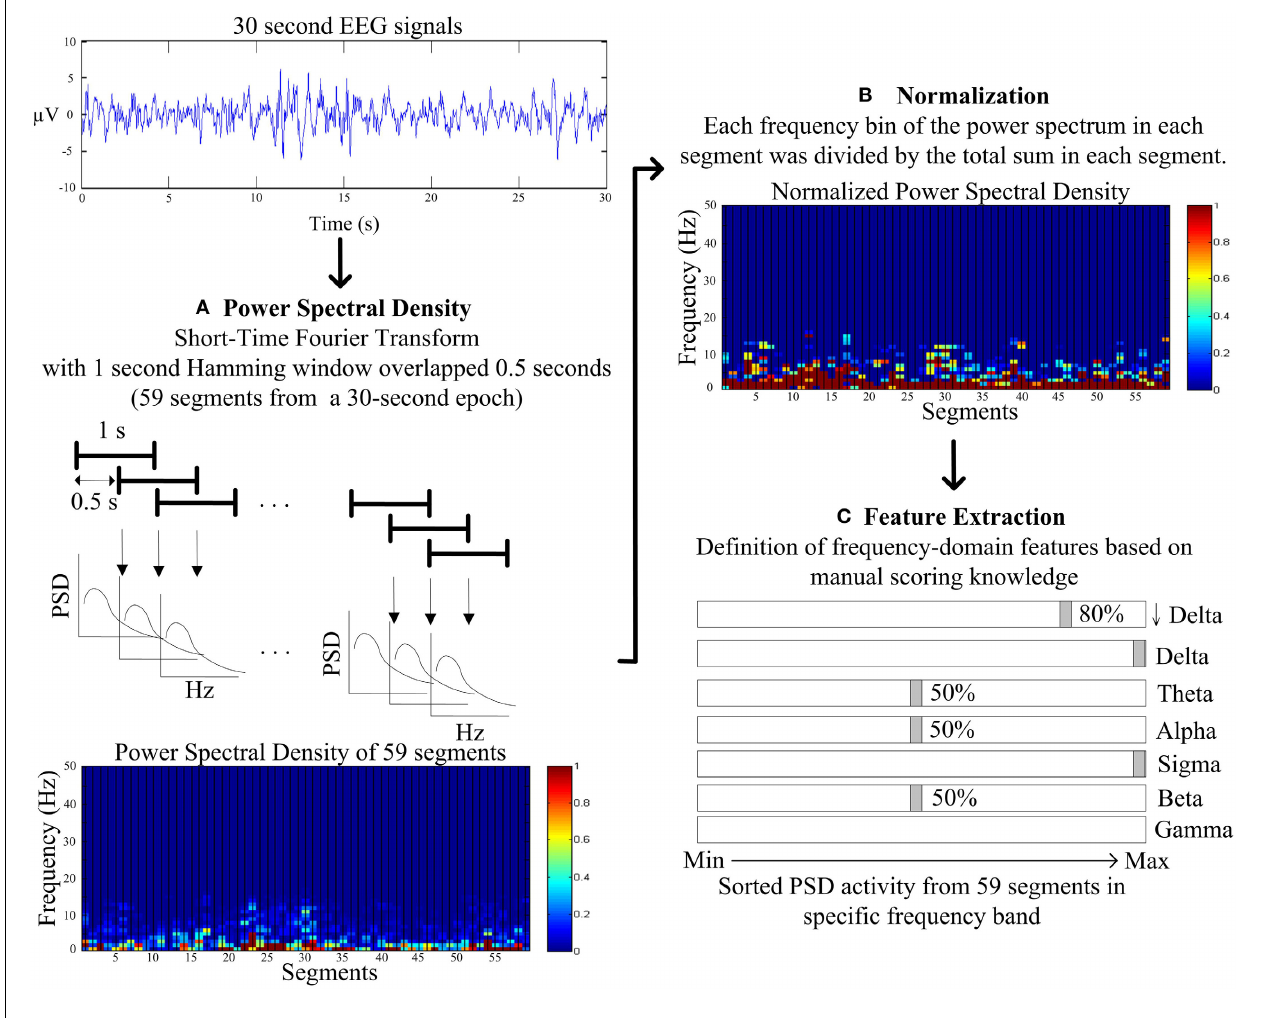
FIGURE 3 | Flowchart of the proposed feature extraction. (A) The power spectral density (PSD) by the short-time Fourier transform (STFT) with a 1s Hamming window overlapped with a 0.5s window. (B) The normalization for